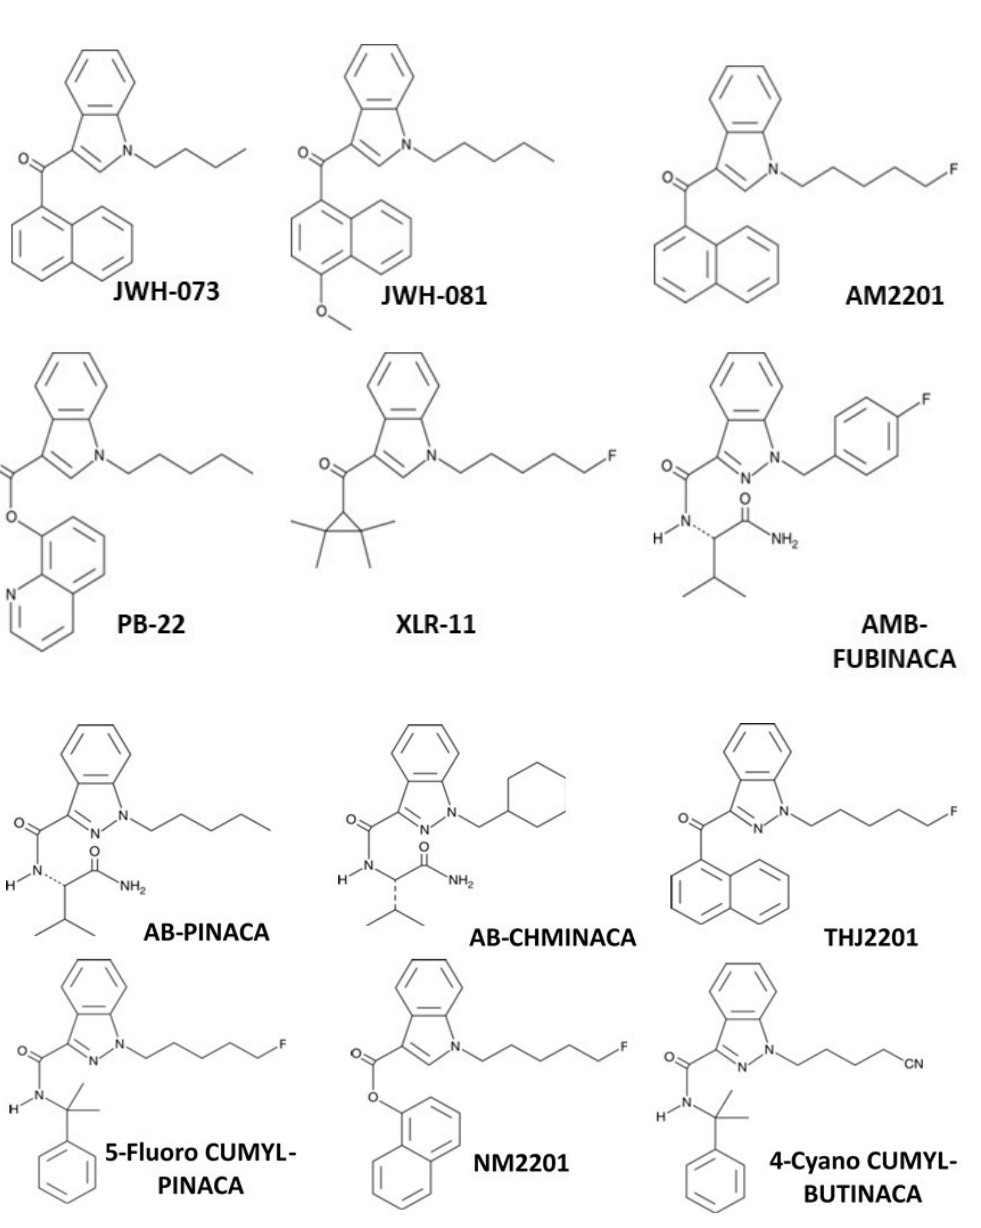
Figure 9. Chemical structures/IUPAC names of selected Schedule I synthetic cannabimimetics.